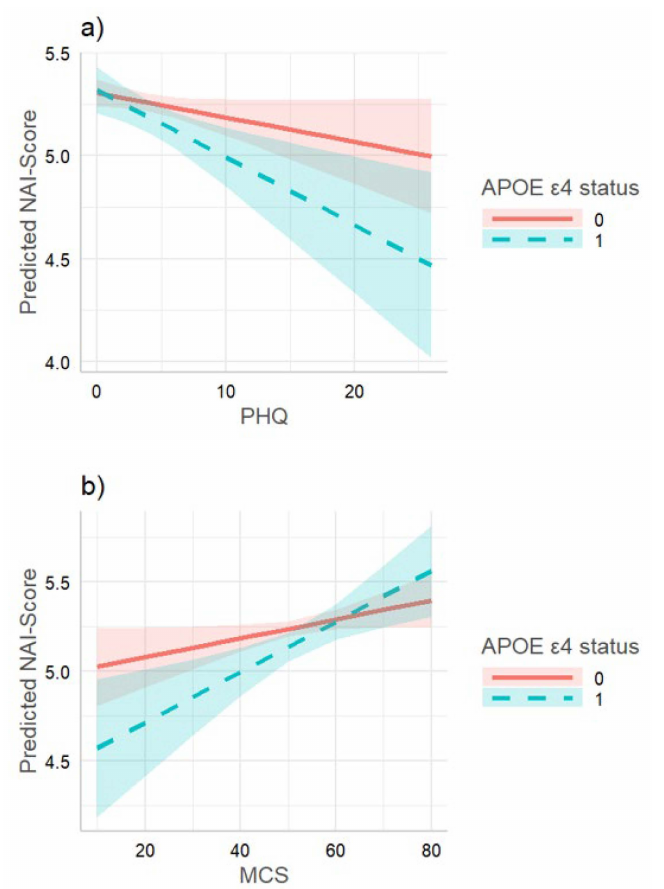
Figure 1. ( a ) Interaction between APOE ε 4 status and PHQ-9 on immediate recall of words in TREND (covariate set 2). Subjects with high PHQ-9 scores and additionally carrying APOE ε 4 revealed lower verbal memory scores than their genetic counterparts did. ( b ) Interaction between APOE ε 4 status and MCS on immediate recall of words in TREND (covariate set 2). Subjects with low MCS scores and additionally carrying APOE ε 4 revealed lower verbal memory scores than their genetic counterparts